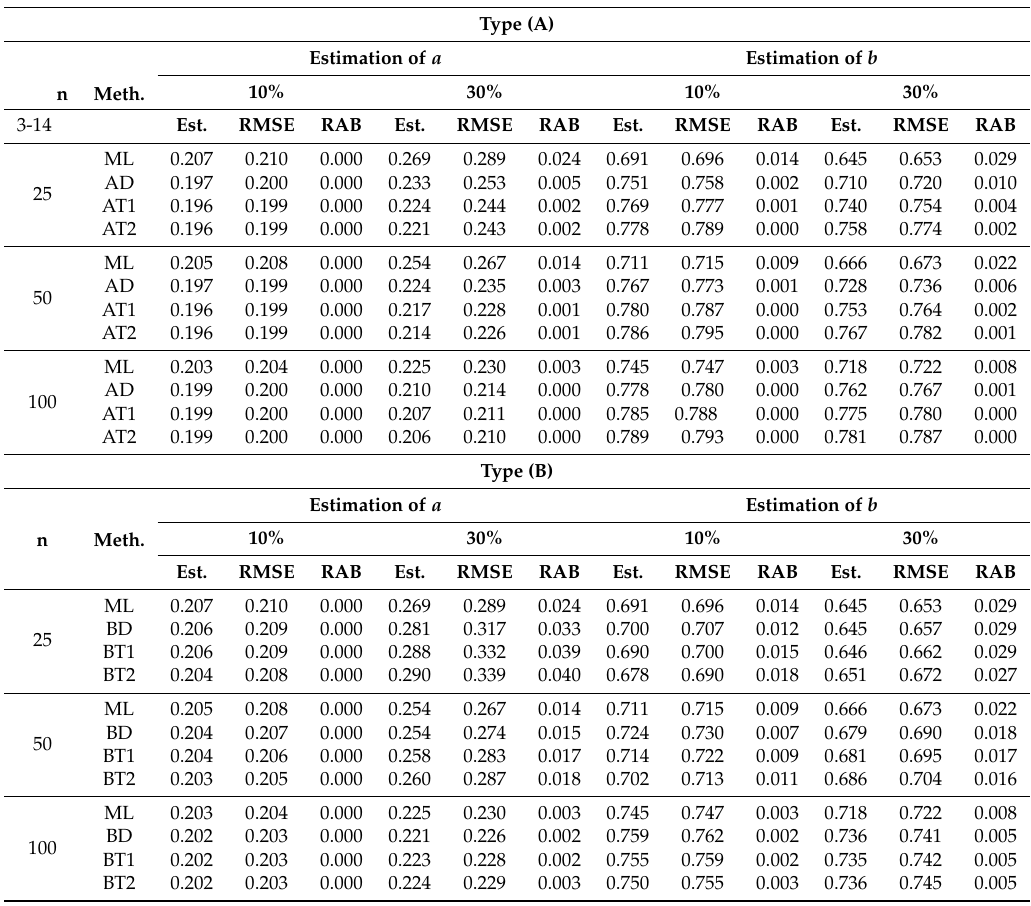
Table 6. The estimates, root of mean square error (RMSE) and relative absolute biases (RABs) for two parameters of the Weibull distribution using TL-moments, direct L-moments, and ML method based on right censoring ( a = 0.2 and b = 0.8) in the presence of